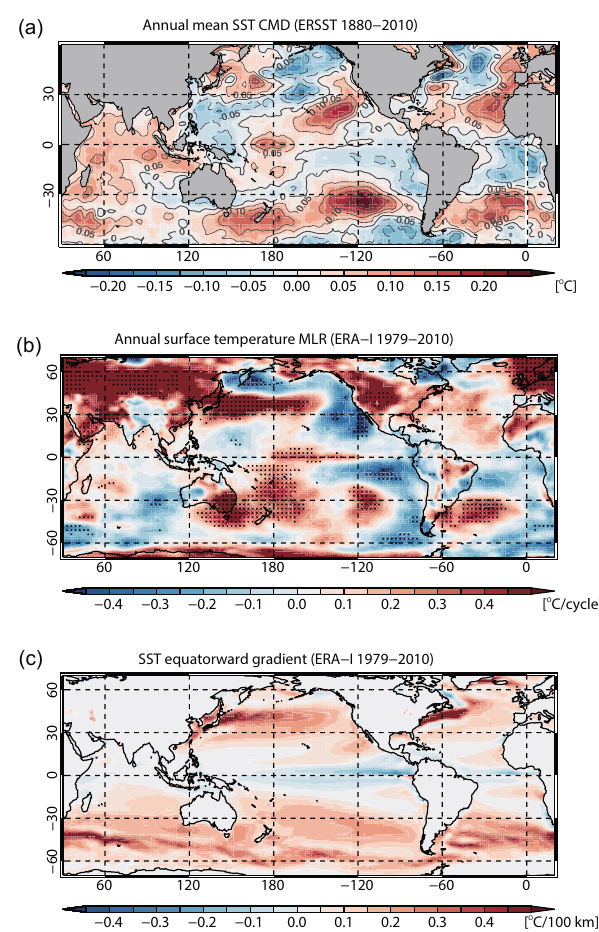
Figure 1. T (a) Annual mean SST anomaly extracted by the same CMD analysis as in Zhou and Tung (2010) for the period 1880– 2010. (b) Annual solar index regression coefficient of the surface temperature derived by applying the MLR model to ERA-I data for the period 1979–2010. Stippled areas indicate statistical signif- icance at the 95% level. (c) Equatorward gradient of annual mean climatological